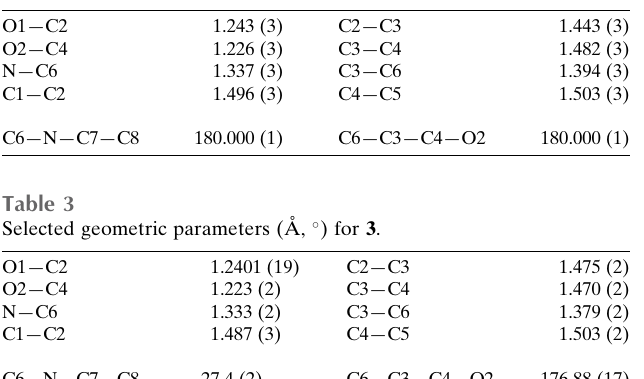
Table 2 Selected geometric parameters (A˚ , (cid:3) ) for 2 .